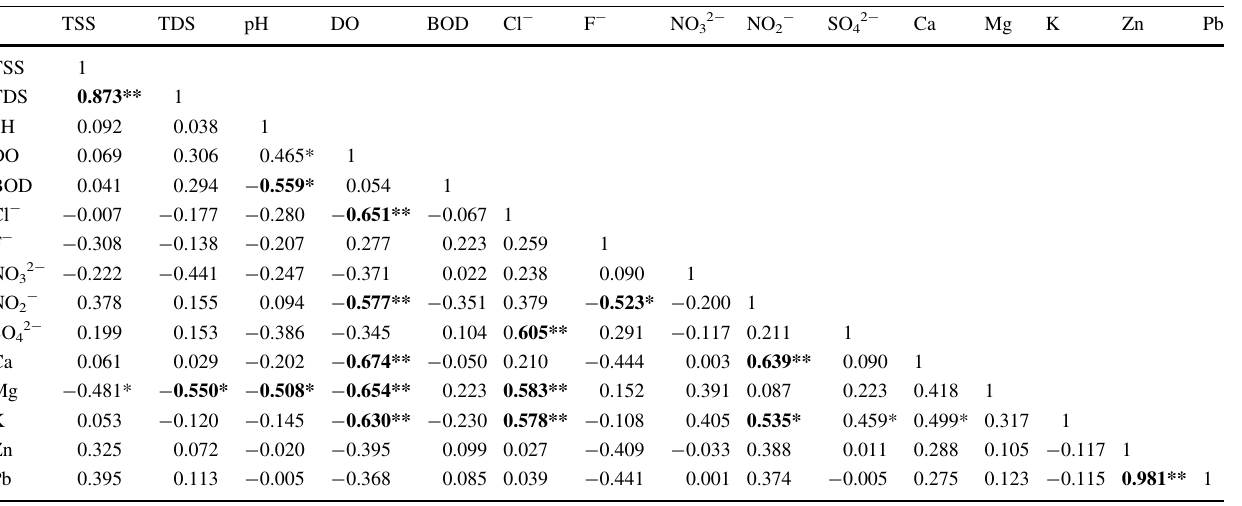
Table 5 Pearson correlation matrix (CM) of water quality